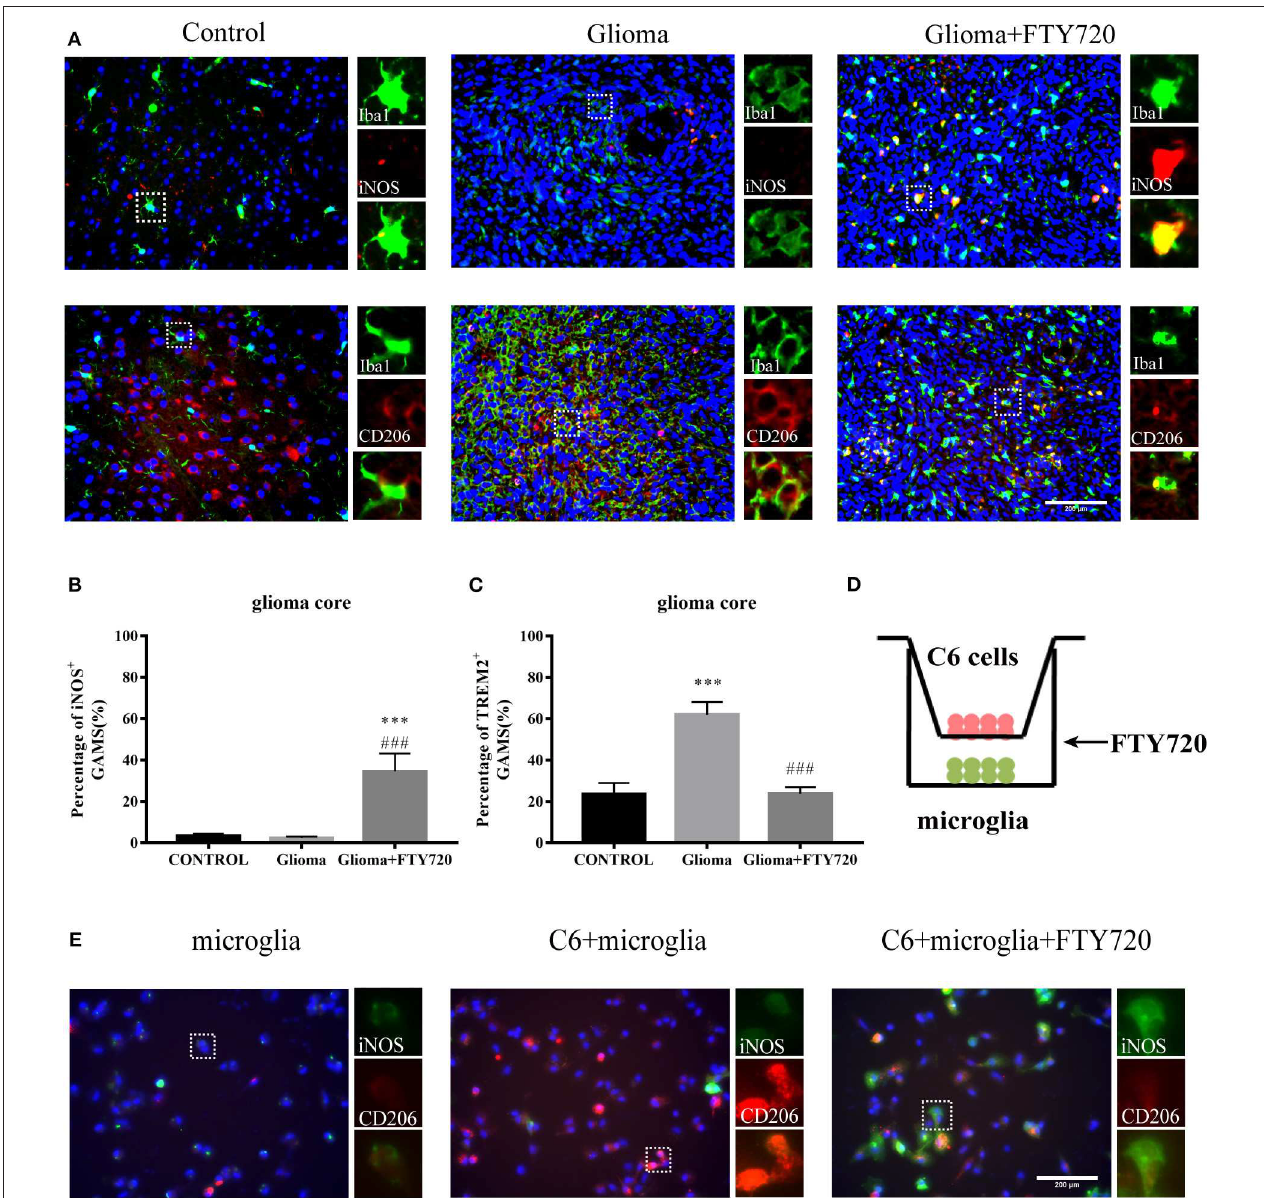
FIGURE 5 | FTY720 impacts microglial polarization. (A) Immunofluorescent analysis of Iba1, iNOS, and CD206 expression in brain sections of C6-bearing rats, respectively. Left panel is 40 × magnification and is amplified in the right panel (40 × ). n = 5–6, scale bar = 200 µ m. (B,C) Representative analysis of iNOS-positive GAMs and CD206-positive GAMs in brain sections. Data are presented as mean ± SEMs, n = 5–6. *** p < 0.001 vs. Control, ### p < 0.001 vs. Glioma. (D) The coculture system of C6 cells and microglia. (E) IF analysis of microglia polarization using M1 marker iNOS (green) and M2 marker CD206 (red). n = 4, scale bar = 100 µ